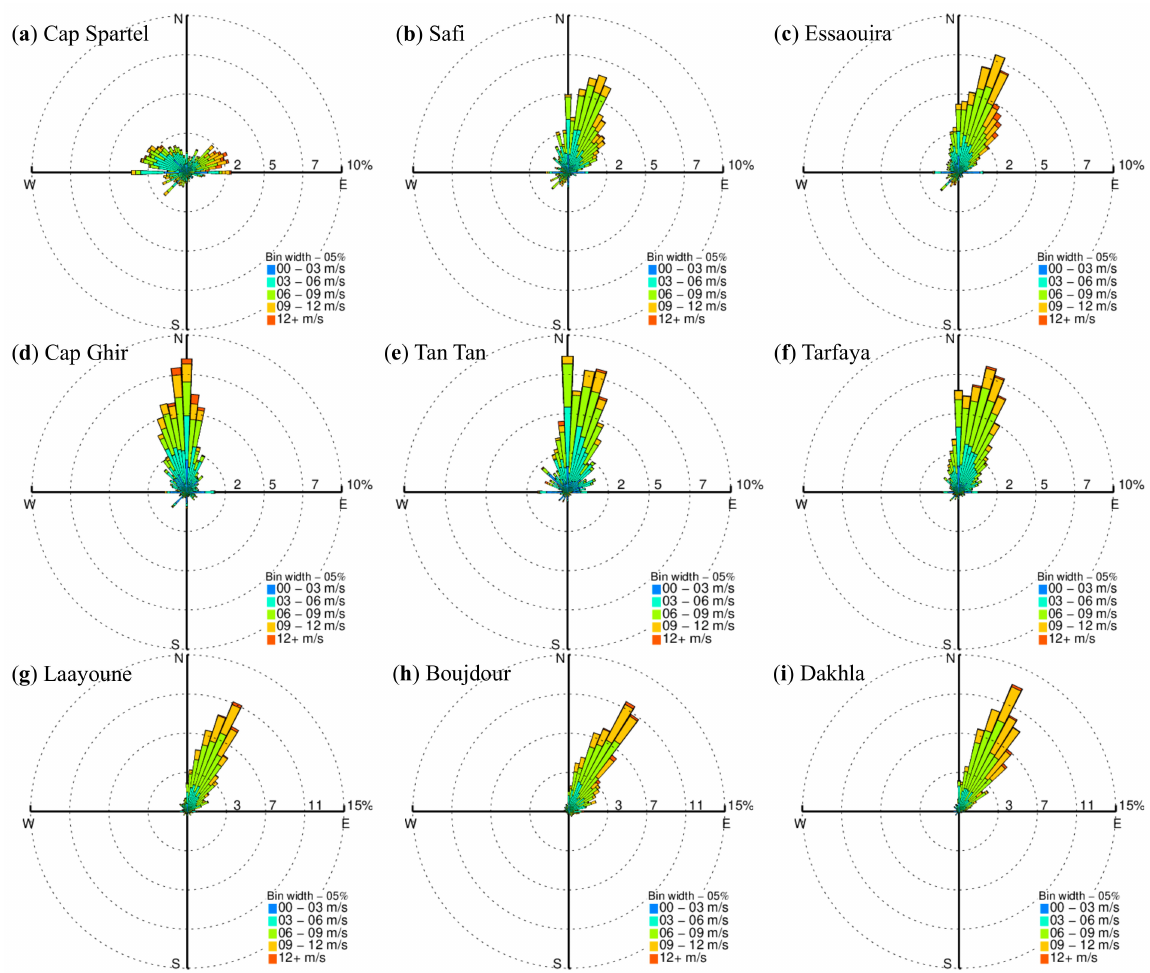
Figure 5. Wind roses diagrams giving measured wind speed frequency and its corresponding wind directions for the nine selected sites; different scales of [0–15%] are used for ( g ) to ( i